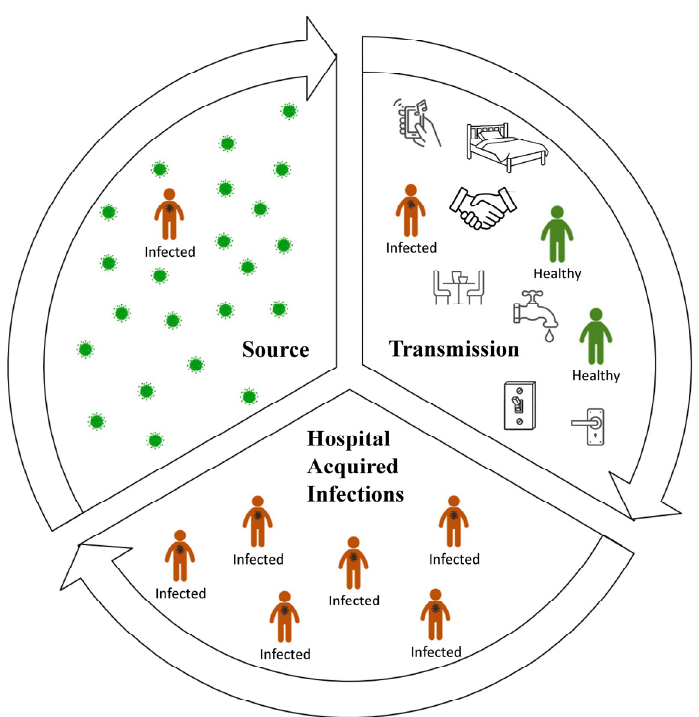
Figure 2. Transmission of HAIs in a healthcare facility. Source: Contaminated surfaces, foodstuff, contaminated hands, saliva, respiratory droplets, faeces and other body fluids, contaminated dust or aerosols, and dispersed skin scales [7,36,47–51]. Transmission: Directly by patient-to-patient contact or contact with carrier healthcare workers; indirectly by fomites including surfaces via contact with patients or via healthcare workers and visitors [3,7,52–56]. HAIs: People inside healthcare facilities are the main reservoir, source of pathogens, main transmitter, and simultaneously, the receptor of pathogens and daily activities inside hospitals enables this cycle to continue [7].